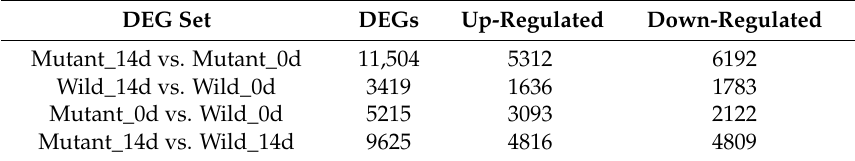
Table 3. DEGs identified from four different comparisons. DEGs: differentially expressed genes. DEG Set